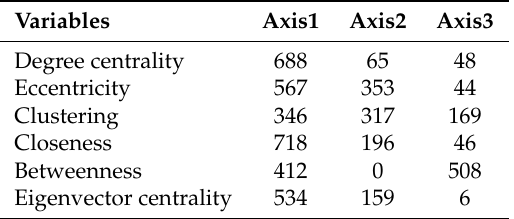
Table 3. Relative contribution of the q-th factor to column element